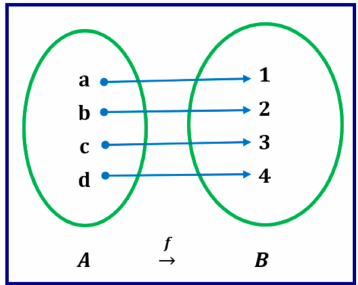
Figure 2. Image similar to the one made by Teacher